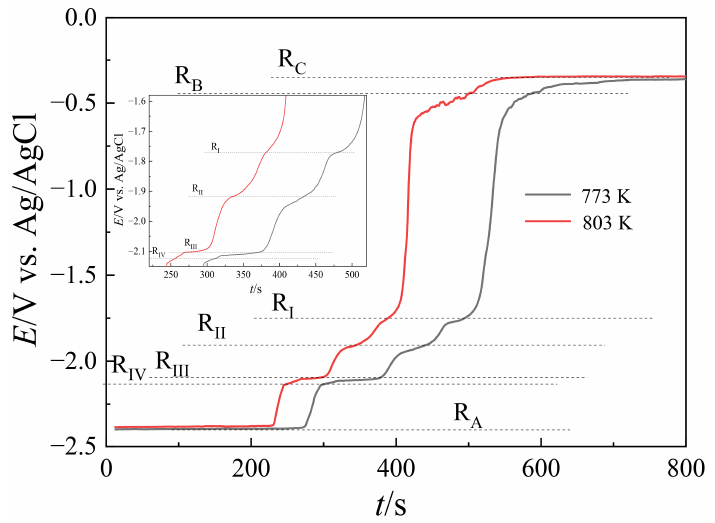
Figure 9. OCP curves recorded on the W electrode in molten LiCl-KCl-YbCl 3 -PbCl 2 ; deposition potential: − 2.5 V; time: 100 s.